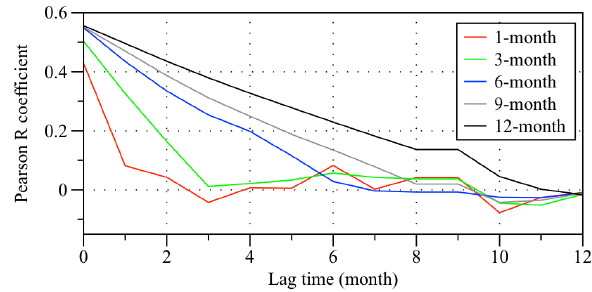
Figure 5. Correlation analysis between SPEI and SSI for different lag